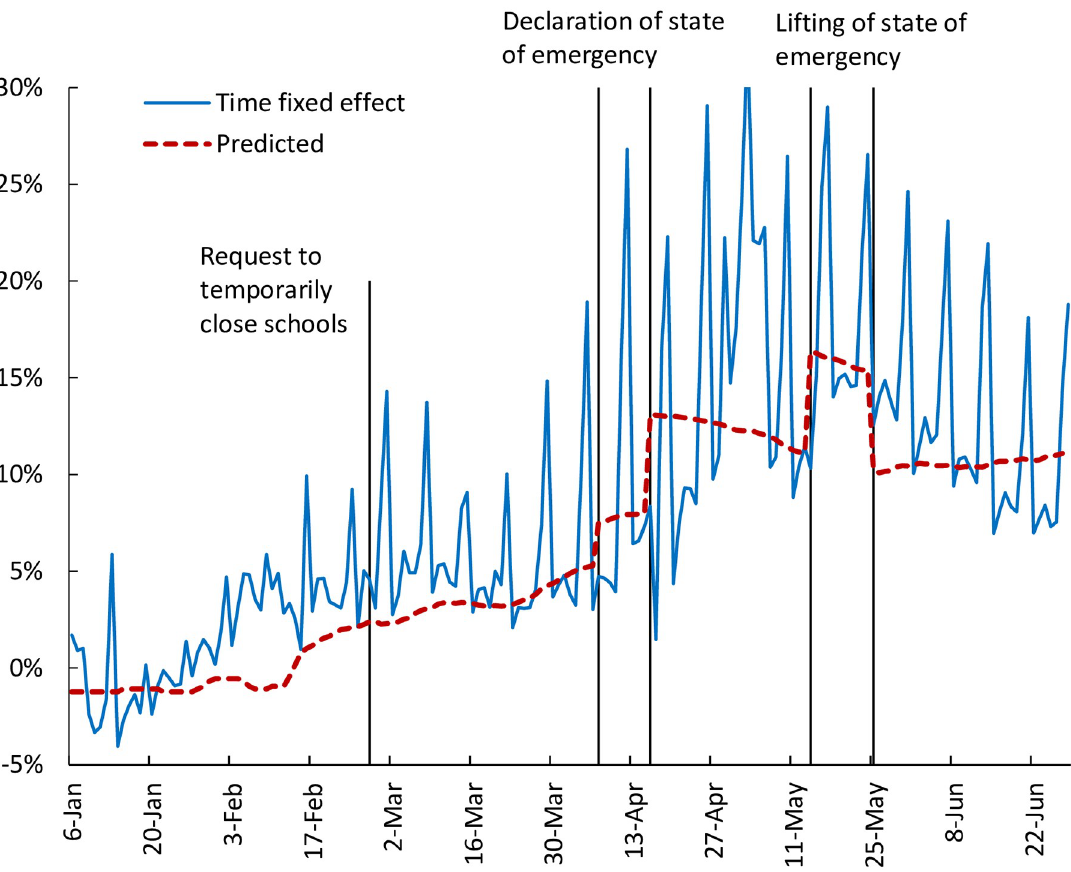
Fig 7. Estimates of time fixed effects. The blue line shows the coefficients on the time dummies. The dotted red line shows the fitted values obtained as follows: (1) we regress the estimated time fixed effects on the number of infections nationwide, the declaration of the state of emergency (April 7 and 16), the lifting of the state of emergency (May 14 and May 25), and Weekend/Holiday dummy; (2) we set the coefficient on the Weekend/Holiday dummy to zero in order to eliminate periodical fluctuations due to the weekend/holiday effect.